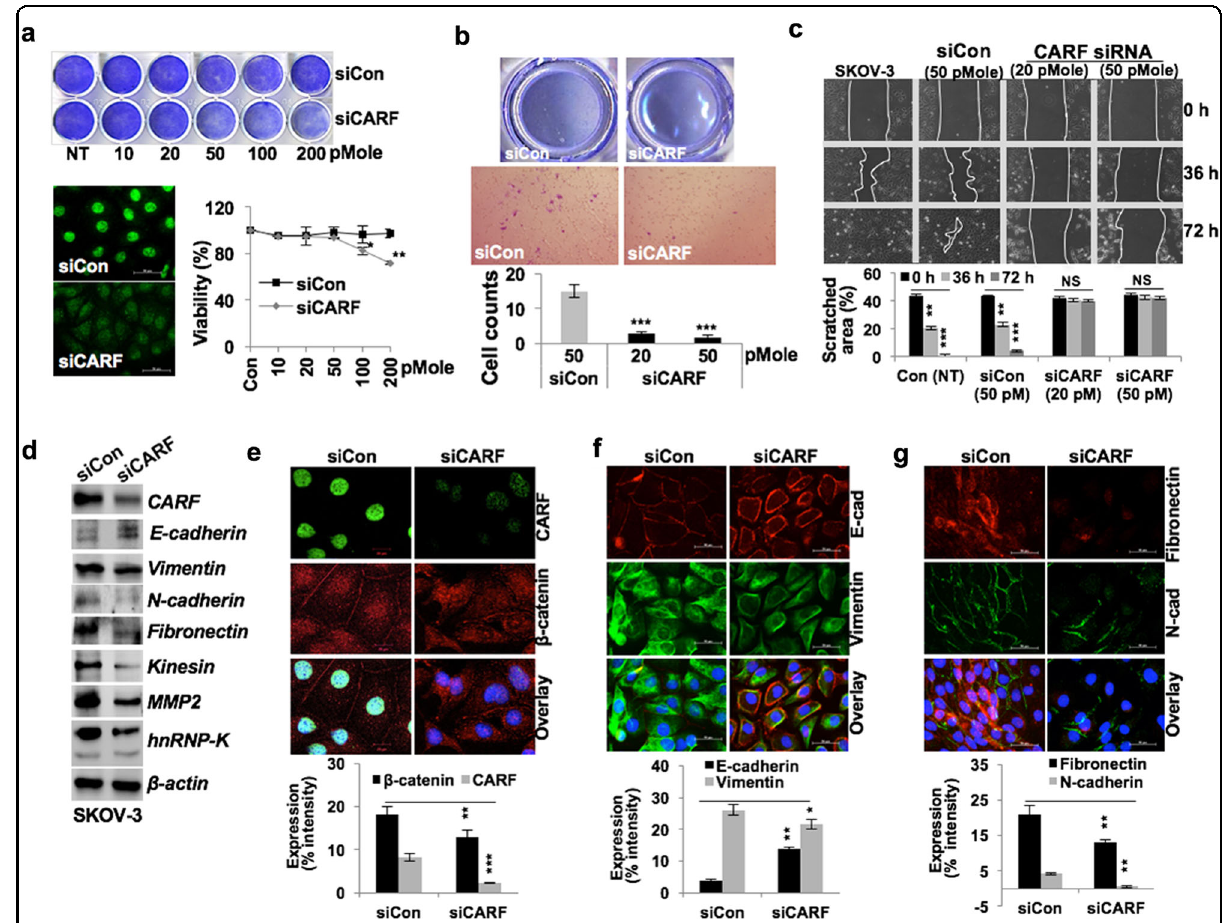
Fig. 5 CARF knockdown attenuated cancer cell invasiveness and abolished EMT phenotype. a Control and CARF siRNA transfected crystal violet-stained SKOV-3 cells showing reduced proliferation in latter with increasing siRNA (10 – 200 pM) concentrations. Immunostaining of CARF (with 50 pM siRNA) and cell viability (10 – 200 pM), respectively. b Invasion assay showing invaded cells and quantitation (below) in control and CARF knockdown cells. c Wound-healing assay (72 h) showing reduced cell migration in CARF knockdown cells; quantitation shown below. d Immunoblotting and e – g immunostaining of CARF, β -catenin ( e ), E-cadherin and vimentin ( f ), and fi bronectin and N-cadherin ( g ), showing decrease in CARF knockdown cells; E-cadherin showed increase; quantitation of their fl uorescence intensities are shown